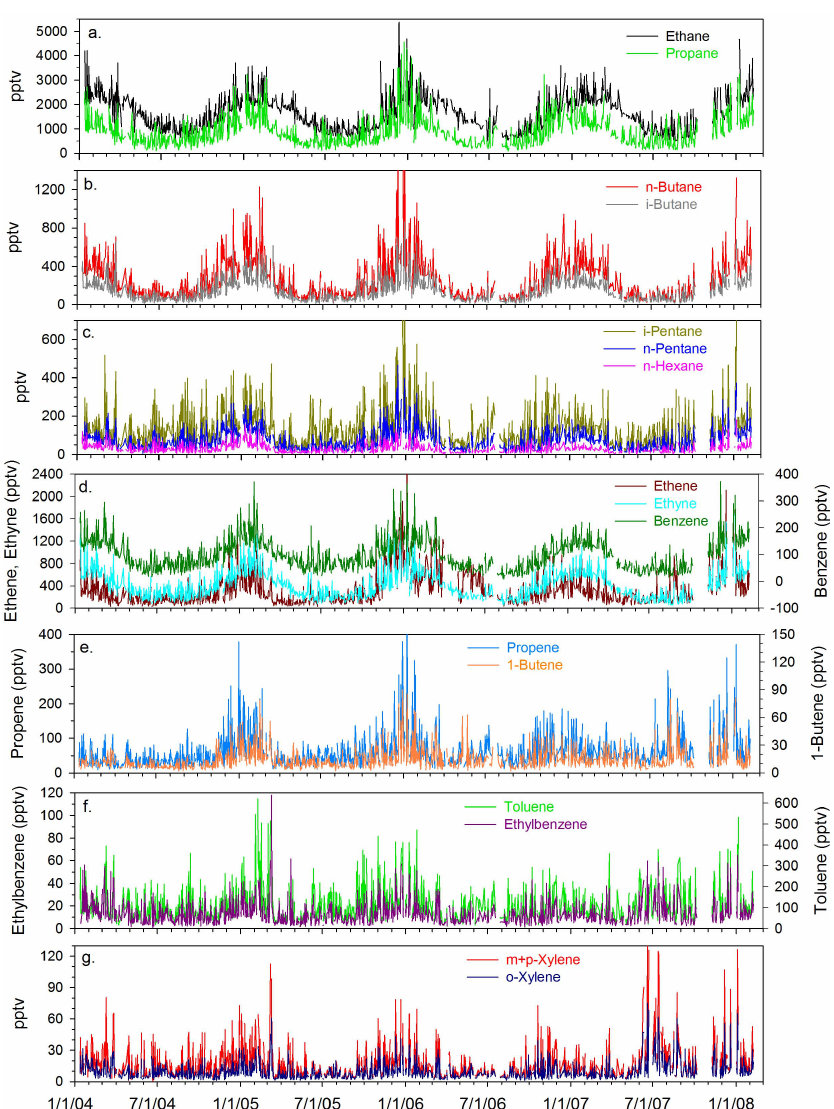
Fig. 3. Time series of NMHCs (pptv) at TF during January 2004–February 2008: (a) ethane, propane, (b) n-butane, i-butane, (c) i-pentane, n-pentane, n-hexane, (d) ethene, ethyne, benzene (note that the benzene axis is offset), (e) propene, 1-butene, (f) toluene, ethylbenzene, and (g) m+p-xylene,